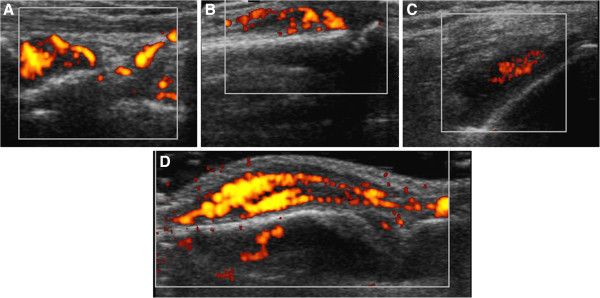
Representative images of ultrasound-defined synovitis in assessed joints. (A) Radiocarpal joint, longitudinal view: synovial hypertrophy (SH) grade 2 and power Doppler ultrasound (PDUS) signal grade 3. (B) Proximal interphalangeal joint, longitudinal view: SH grade 2 and PDUS signal grade 2. (C) Knee joint: parapatellar recess, transversal view: SH grade 2 and PDUS signal grade 2. (D) Metacarpophalangeal joint, longitudinal view: SH grade 2 and PDUS signal grade 3.